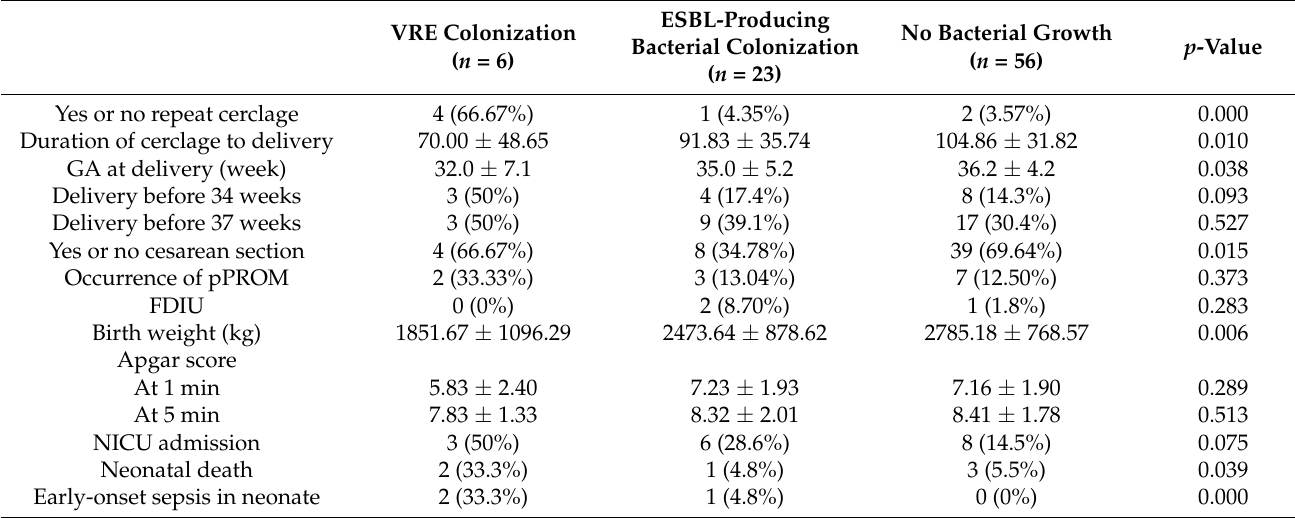
Table 3. Neonatal outcomes in patients who underwent emergency